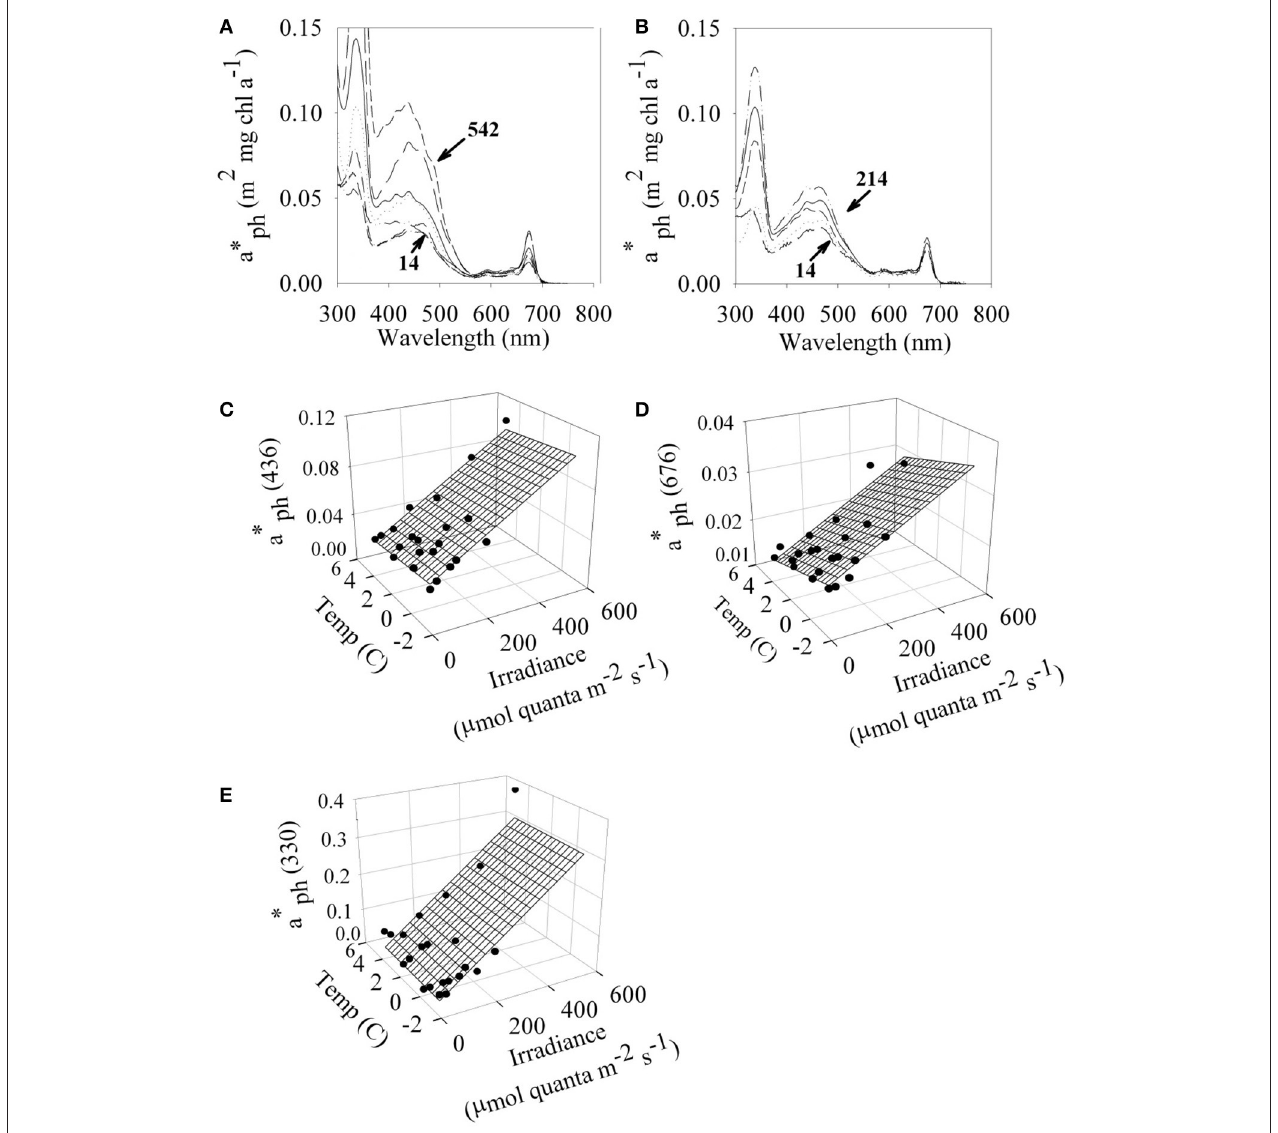
FIGURE 2 | Absorption characteristics of P. antarctica. In vivo chl-specific absorption spectrum (a* ph ( λ )) for P. antarctica grown at (A) 4C and (B) − 1.5 ◦ C between a range of irradiances ( µ mol quanta m − 2 s − 1 ). Irradiance- and temperature- dependent values of a* ph (circles) at (C) 436nm (D) 676nm and (E) 330nm. Multiple linear regressions based on temperature and light (continuous surface) are overlaid on the discrete points of a* ph ( λ ). Each point represents the average of 4 replicates. C.V. for a* ph ( λ ) values are